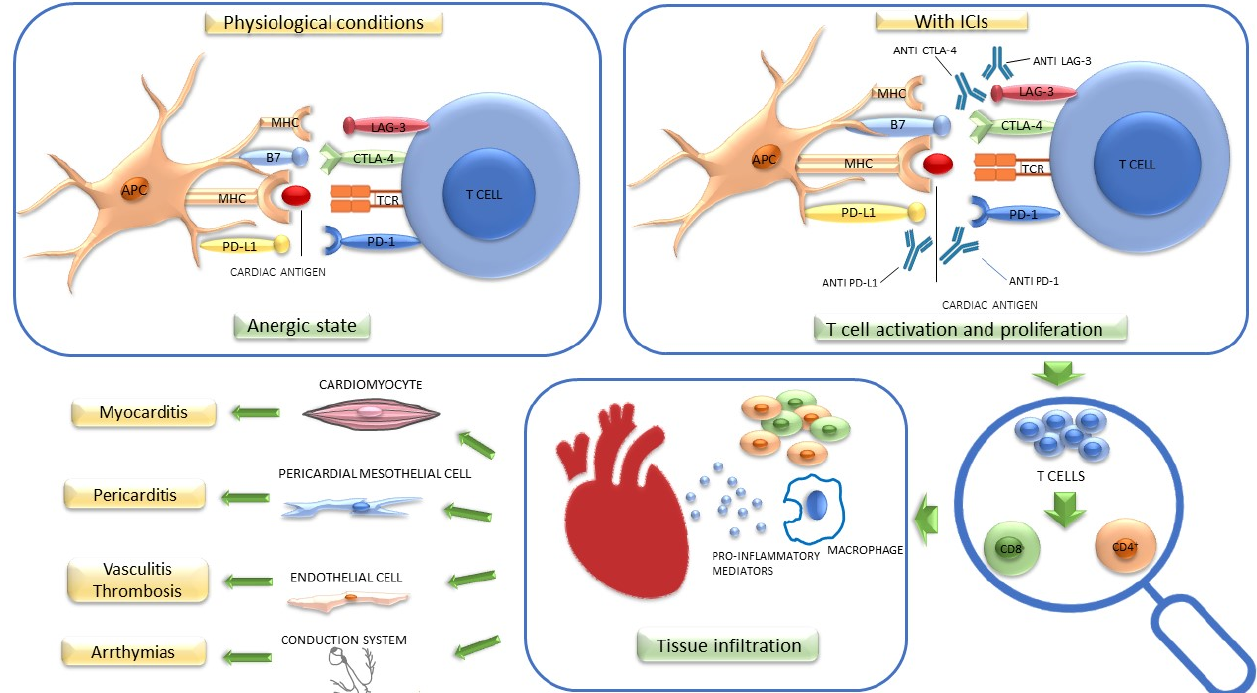
Figure 1. Potential pathogenetic mechanism of cardiotoxicity induced by immune checkpoint in- hibitors (ICIs). Under physiological conditions, the activation of the PD1/PD-L1 axis maintains T cells in an anergic state, while CTLA-4 competes with CD80/CD86 to induce a decrease in T cell activation. LAG3 interacts with MHC and upregulates T cells function, downregulates TCR signal transduction, and reduces cytokine production. The inhibition of these immune checkpoints by ICIs may mediate the proliferation of these cells, which, through an antigenic cross-reactivity mechanism, induces cardiac damage on multiple levels. APC: antigen-presenting cell; B7: CD80/CD86; CTLA-4: cytotoxic T-lymphocyte-associated protein; LAG-3: lymphocyte-activation gene 3; MHC: major histocompatibility complex; PD1: programmed cell death protein 1; PD-L1: programmed death ligand 1; TCR: T cell receptor.